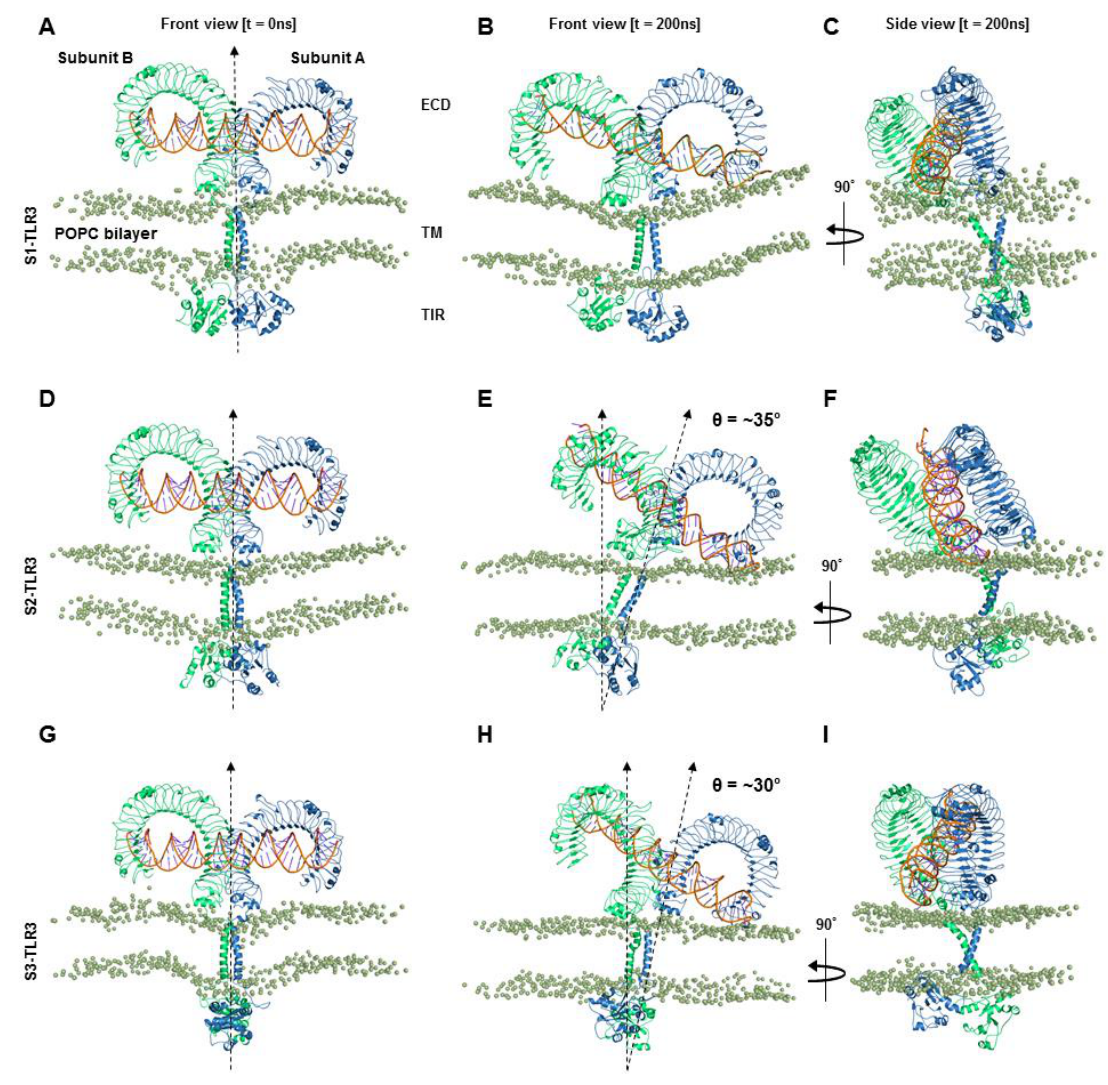
Figure 1. Overall structure of Toll-like receptor (TLR3) in 1-palmitoyl-2-oleoyl-sn-glycero-3-phosphocholine (POPC) bilayers. ( A ) Initial structure of S1-TLR3 (0 ns). ( B ) Final snapshot structure of S1-TLR3 (200 ns). ( C ) Side view of panel B (90° rotation). ( D ) Initial structure of S2-TLR3. ( E ) Final snapshot structure of S2-TLR3. ( F ) Side view of panel E. ( G ) Initial structure of S3-TLR3. ( H ) Final snapshot structure of S3-TLR3. ( I ) Side view of panel G. Subunits A and B are colored blue and green, respectively. The phosphate atoms of the bilayer lipids are shown as mauve beads. S1, S2, and S3 represent replicate 2 of simulation set 1, 2, and 3, respectively. ECD, extracellular domain; TM, transmembrane domain; TIR, Toll/interleukin receptor domain; TLR3, Toll-like receptor 3; POPC, 1-palmitoyl-2-oleoyl-sn-glycero-3-phosphocholine; t, simulation time; θ, tilt angle of ECD with respect to the bilayer normal.